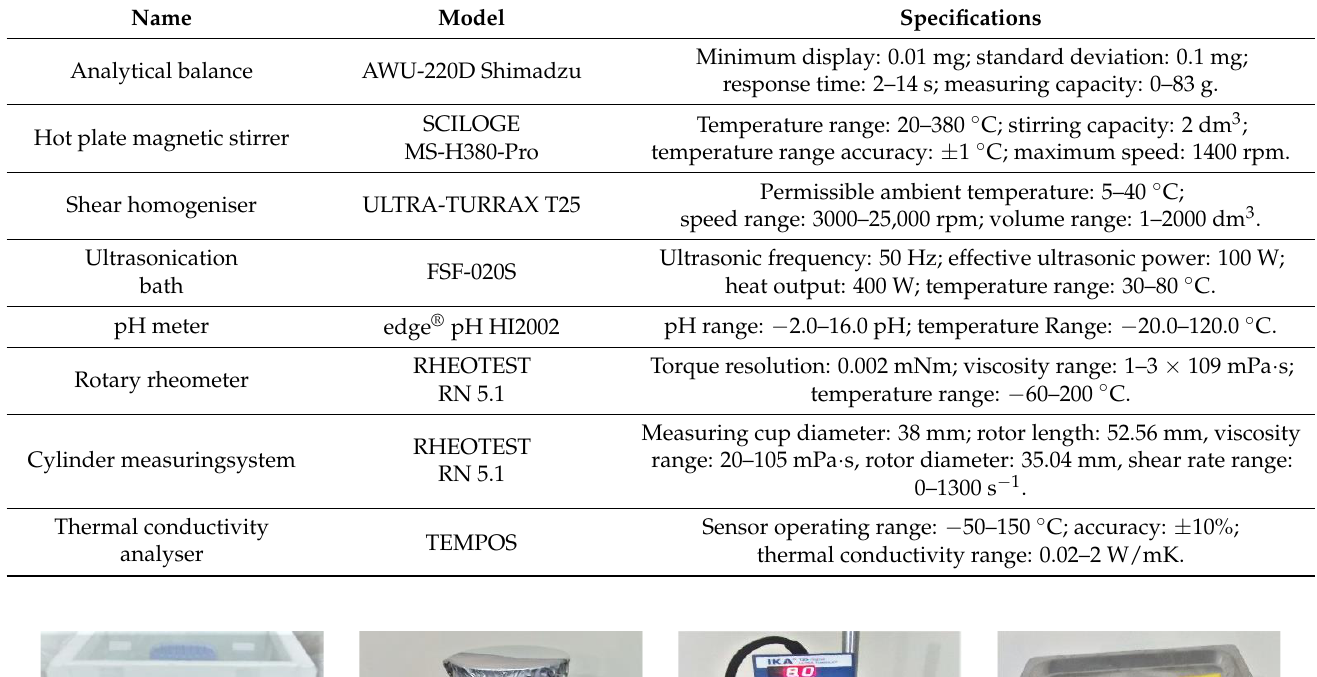
Table 4. Specifications for equipment used in nanofluid preparation and characterisation.